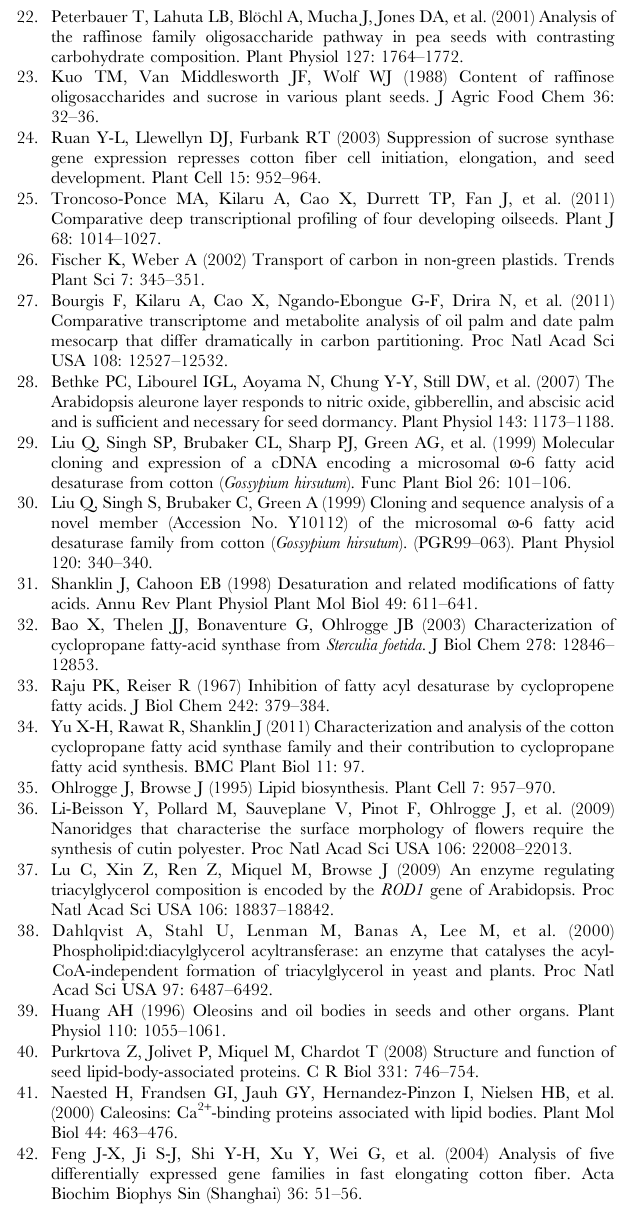
Table S1 A list of miRNAs in cotton developing embryos. (XLSX) Table S2 A list of genes encoding transcription factors. (XLSX) Table S3 A list of genes involved in providing pyruvate for fatty acid synthesis. (XLSX) Table S4 A list of galactosyltransferases involved in oligosaccharides synthesis. (XLSX) Table S5 Expression profile of genes involved in lipid metabolism. (XLSX)